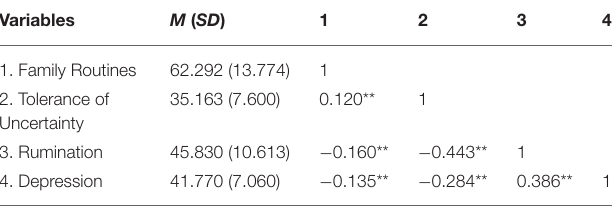
TABLE 1 | Means, standard deviations, and correlations among study variables.